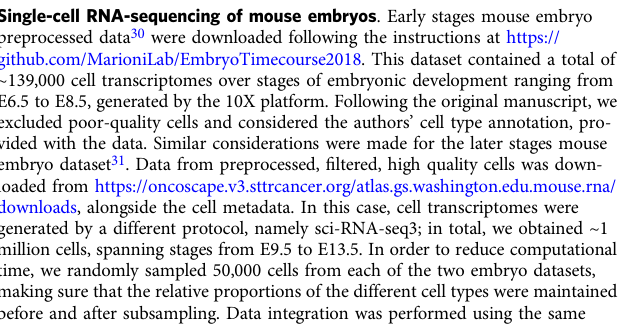
Table 4). Differential expression analysis was computed on the unintegrated data using MAST algorithm 88 . Statistically signi fi cant genes were considered having a q-value < 0.05 (Bonferroni